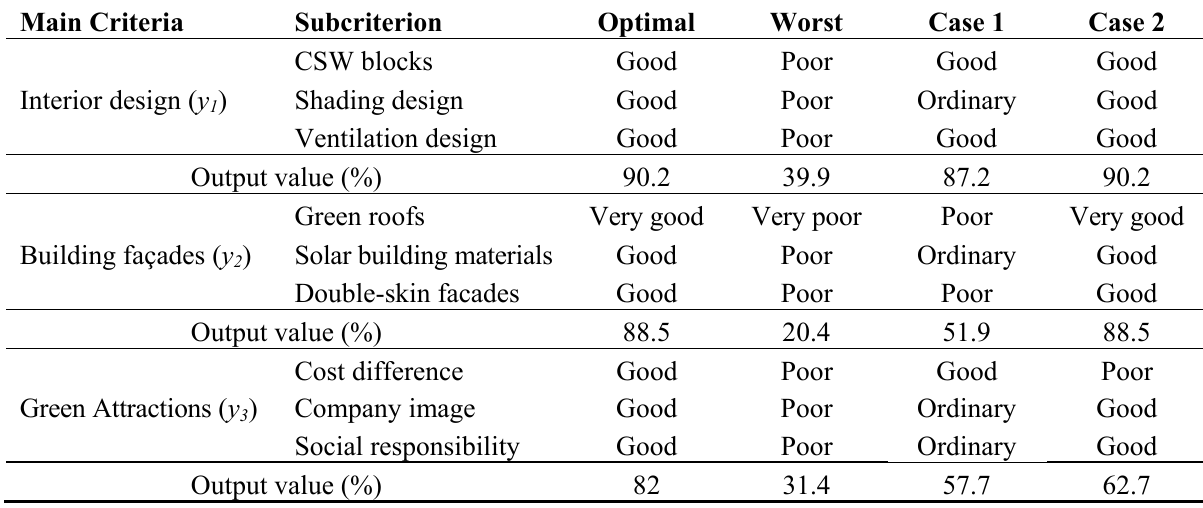
Table 9. The optimal and worst output value for each